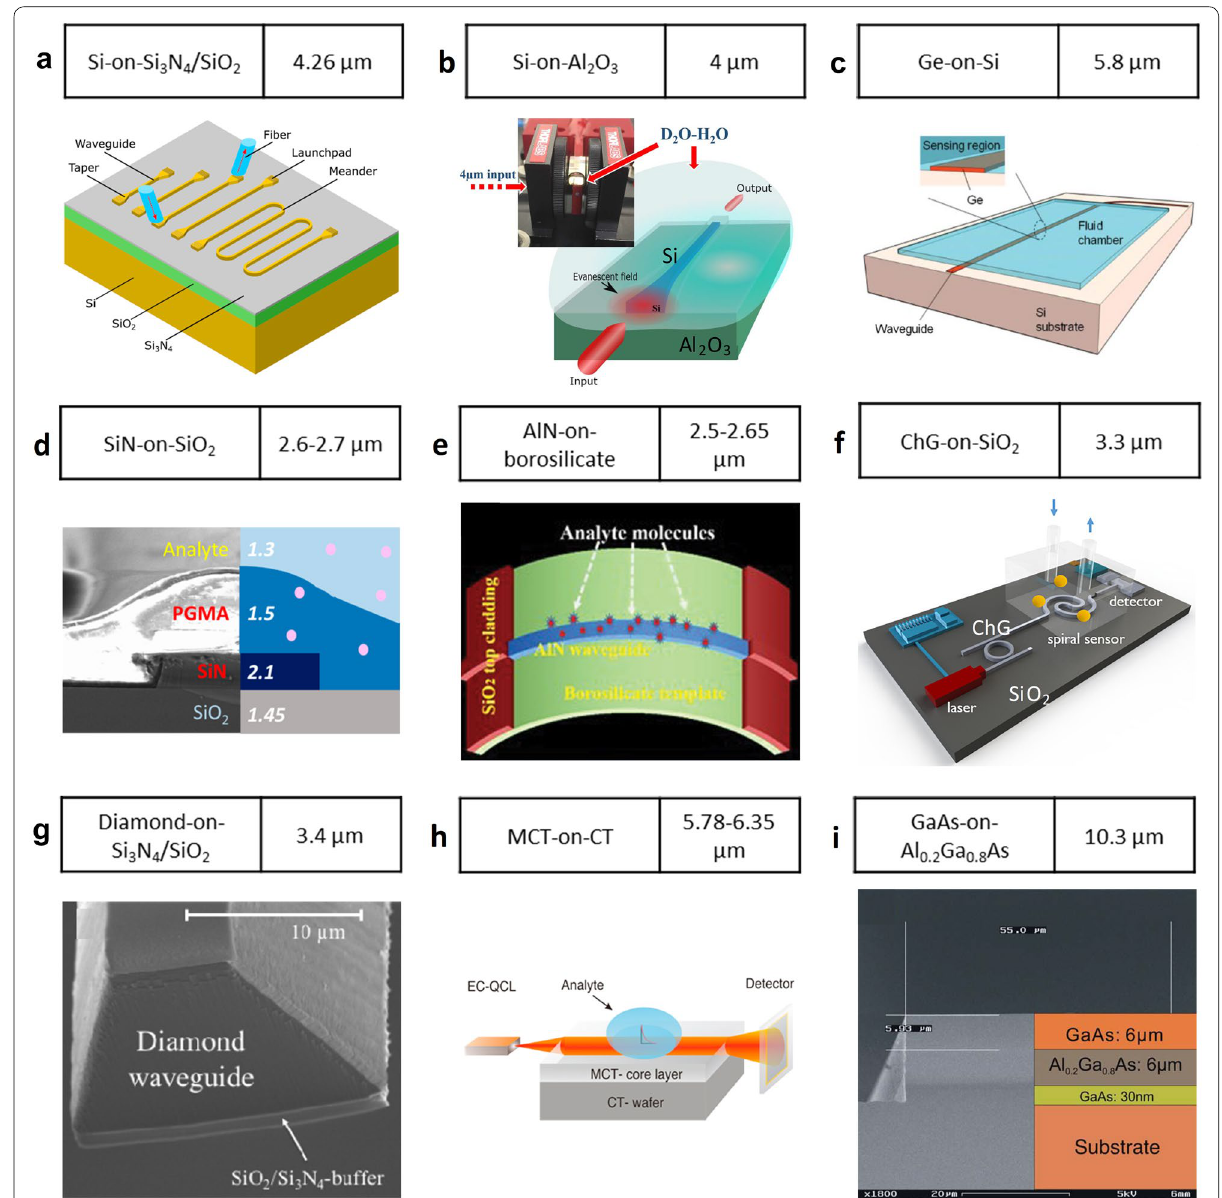
Fig. 6 Typical material platforms for MIR guided-wave nanophotonic biochemical sensors. a Silicon-on-insulator (Reproduced with permission from [145]). b Silicon-on-sapphire (Reproduced with permission from [146]). c Germanium-on-silicon (Reproduced with permission from [147]). d Silicon nitride-on-insulator (Reproduced with permission from [148]). e Aluminum nitride-on-borosilicate (Reproduced with permission from [149]). f Chalcogenide-on-insulator (Reproduced with permission from [150]). g Diamond-on-insulator (Reproduced with permission from [151]). h Mercury cadmium telluride-on-cadmium telluride (Reproduced with permission from [152]). i Gallium arsenide-on-Al 0.2 Ga 0.8 As(Reproduced with permission from